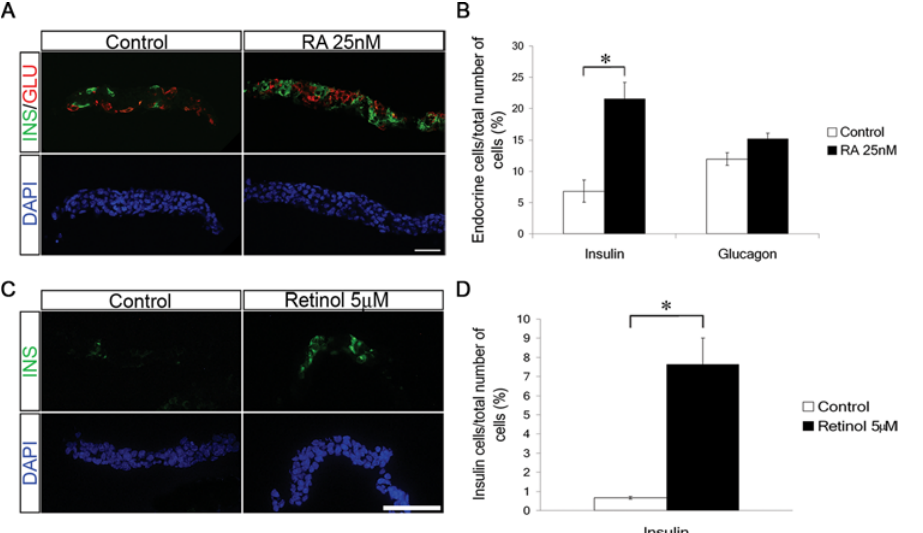
Figure 2. RA stimulates b -cell differentiation invitro . ( A ) Representative sections of control and RA-treated e10.5 dorsal pancreatic explants cultured for 6 days and analyzed for insulin (green) and glucagon (red) expression. ( B ) Quantification of insulin and glucagon positive cells in control pancreatic explants and pancreatic explants exposed to RA for 6 days (n=6 for both) displayed as % positive cells/total number of cells. ( C ) Representative sections of control and retinol-treated e10.5 pancreatic explants cultured for 6 days and stained with antibodies against insulin (green). ( D ) Quantification of insulin expression in control and retinol-treated pancreatic buds (n=2 for both). Scale bar=40 m M in ( A ) and 30 m M in ( C ). Data show mean 6 S.E.M, *p , 0.05.